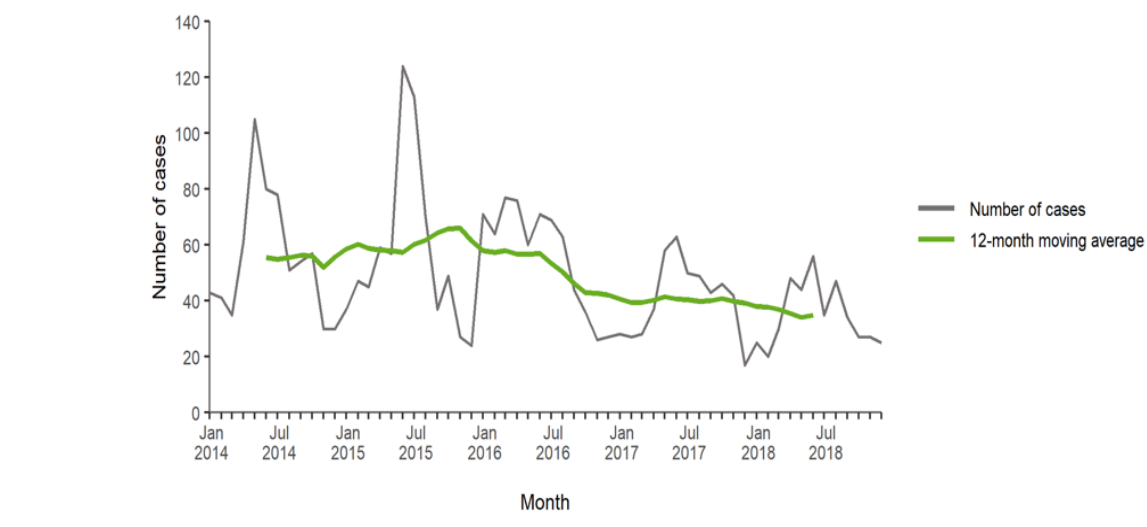
Figure 2. Distribution of confirmed Q fever cases by month, EU/EEA, 2014–2018